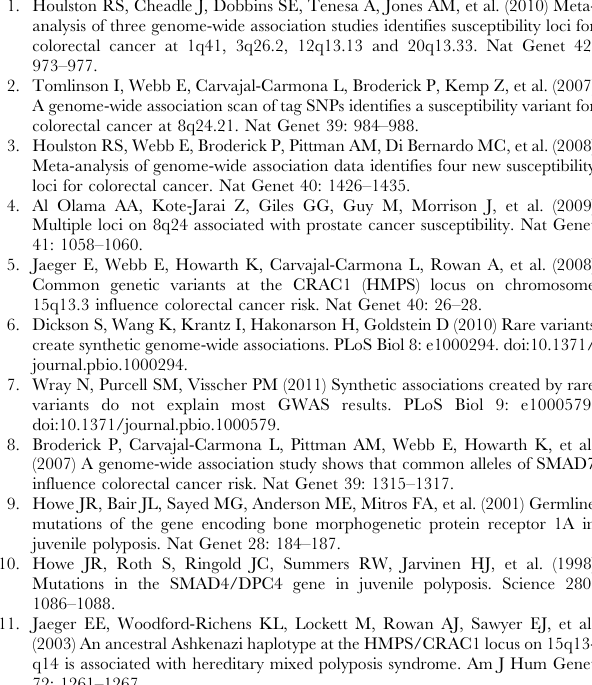
Figure S1 Fine mapping around the known CRC risk SNPs Figure S2 Pairwise linkage disequilibrium between rs4779584, rs16969681 and rs11632715 near GREM1 (upper) and position of recombination hotspot (lower). Figure S3 Histone methylation and acetylation marks upstream of GREM1 . Figure S4 Study design for discovery and validation phases. Figure S5 Large-scale LD structure in regions around BMP4 and BMP2 . Figure S6 Locations of recombination hotspots in regions around BMP4 and BMP2 . Table S1 SNPs genotyped directly or predicted by imputation in the fine mapping of the regions around rs4779584, rs4444235, and rs961253 in UK2 and Scotland2.